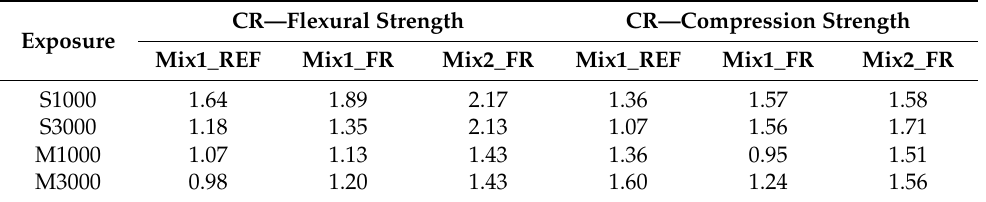
Table 8. Effect of environmental conditioning (CR) on flexural strength and compression